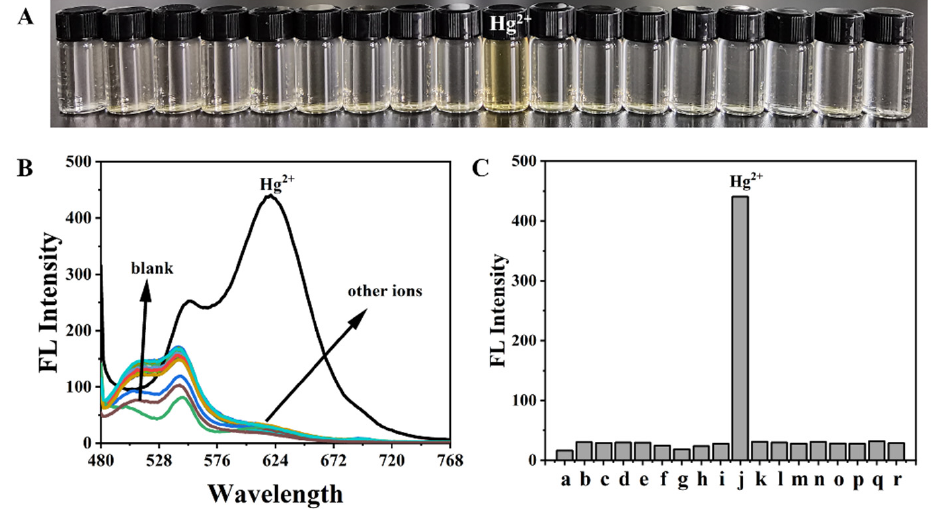
Figure 7. ( A ) Color comparison of solutions under sunlight, ( B ) fluorescence spectra ( λ ex = 450 nm) and ( C ) bar graphs of maximum fluorescence intensity (a = blank, b = K + , c = Ca 2+ , d = NH 4+ , e = Mn 2+ , f = Cr 3+ , g = Cu 2+ , h = Cu + , i = Pb 2+ , j = Hg 2+ , k = Fe 2+ , l = Ni 2+ , m = Cd 2+ , n = Co 2+ , o = Al 3+ , p = Ba 2+ , q = Na + , r = Ag + ) in 99% aqueous solution (V H2O :V DMSO = 99:1) containing probe ([BNEA] = 10 μ M) and different cations ([Ions] = 10 μ M) .